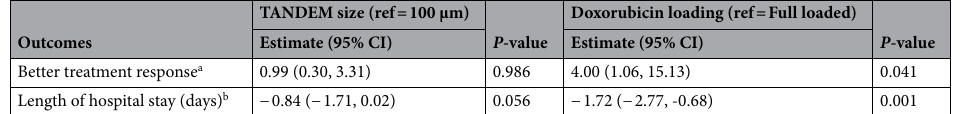
TANDEM size (ref = 100 μm)